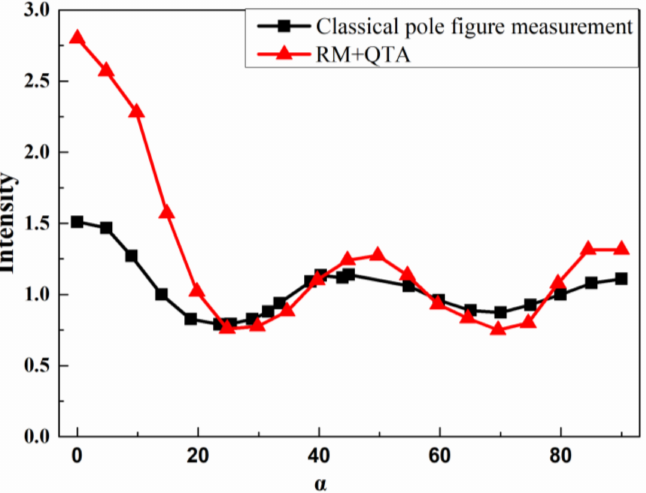
Figure 3. Pole-axis distribution plots for (311) silver film derived from the classical pole figure measurement and Rietveld method and quantitative texture analysis (RM + QTA) ( β =